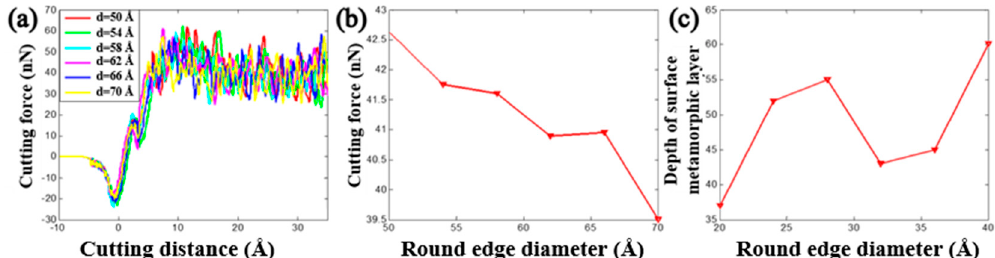
Figure 12. The cutting force and depth of surface metamorphic layer obtained from QC by varying the tool rounded edge diameter. ( a ) Cutting force vs. the cutting distance under different tool rounded edge diameter d; ( b ) evolution of the average cutting force when varying the tool rounded edge diameter and ( c ) evolution of the depth of the surface metamorphic layer when varying the tool rounded edge diameter d.